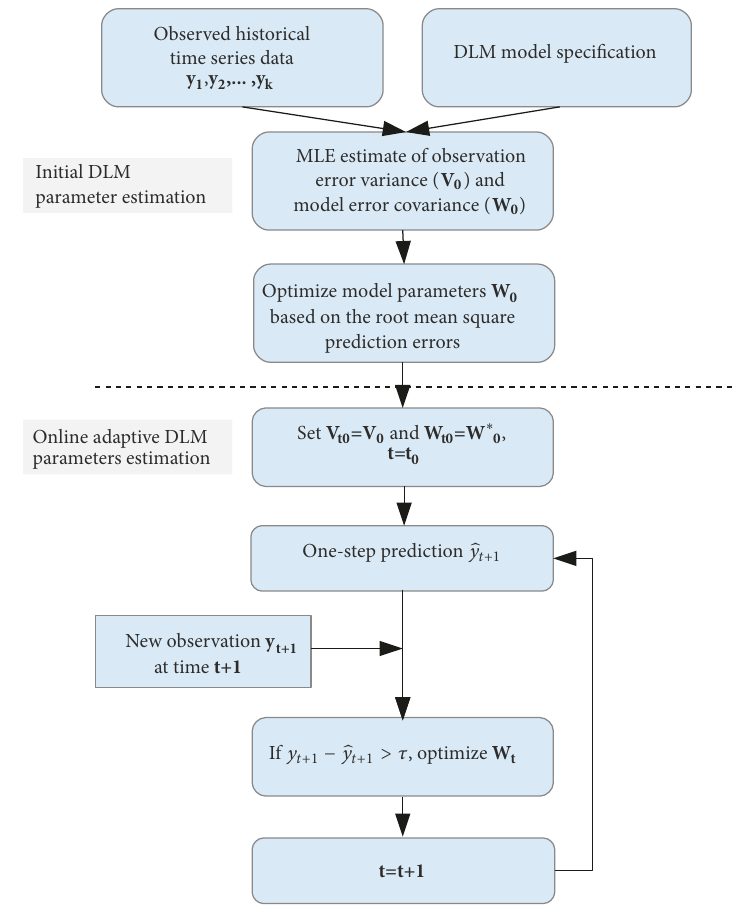
Figure 1: Online adaptive parameter updating approach.